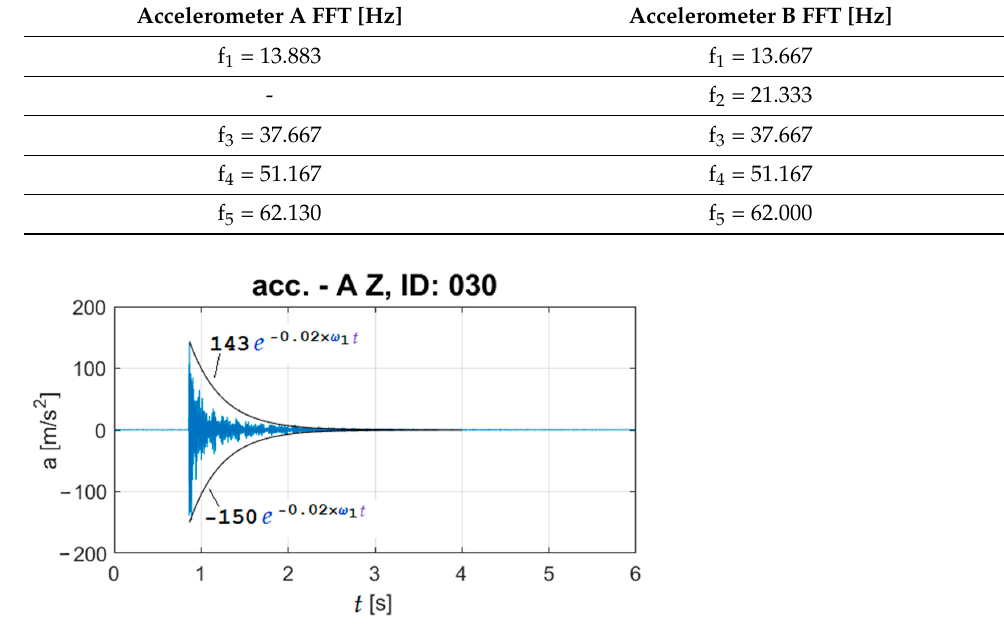
Figure 14. The envelope curves with for measurement ID 30, using the first eigenfrequency, where e is the mathematical constant here. This roughly estimated value will be used for cross-checking against the FEM calculations.